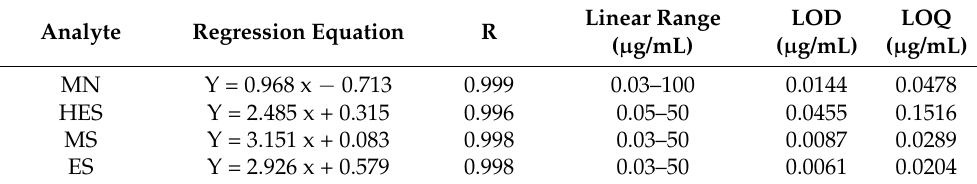
Table 1. The results of regression equations, LOD and